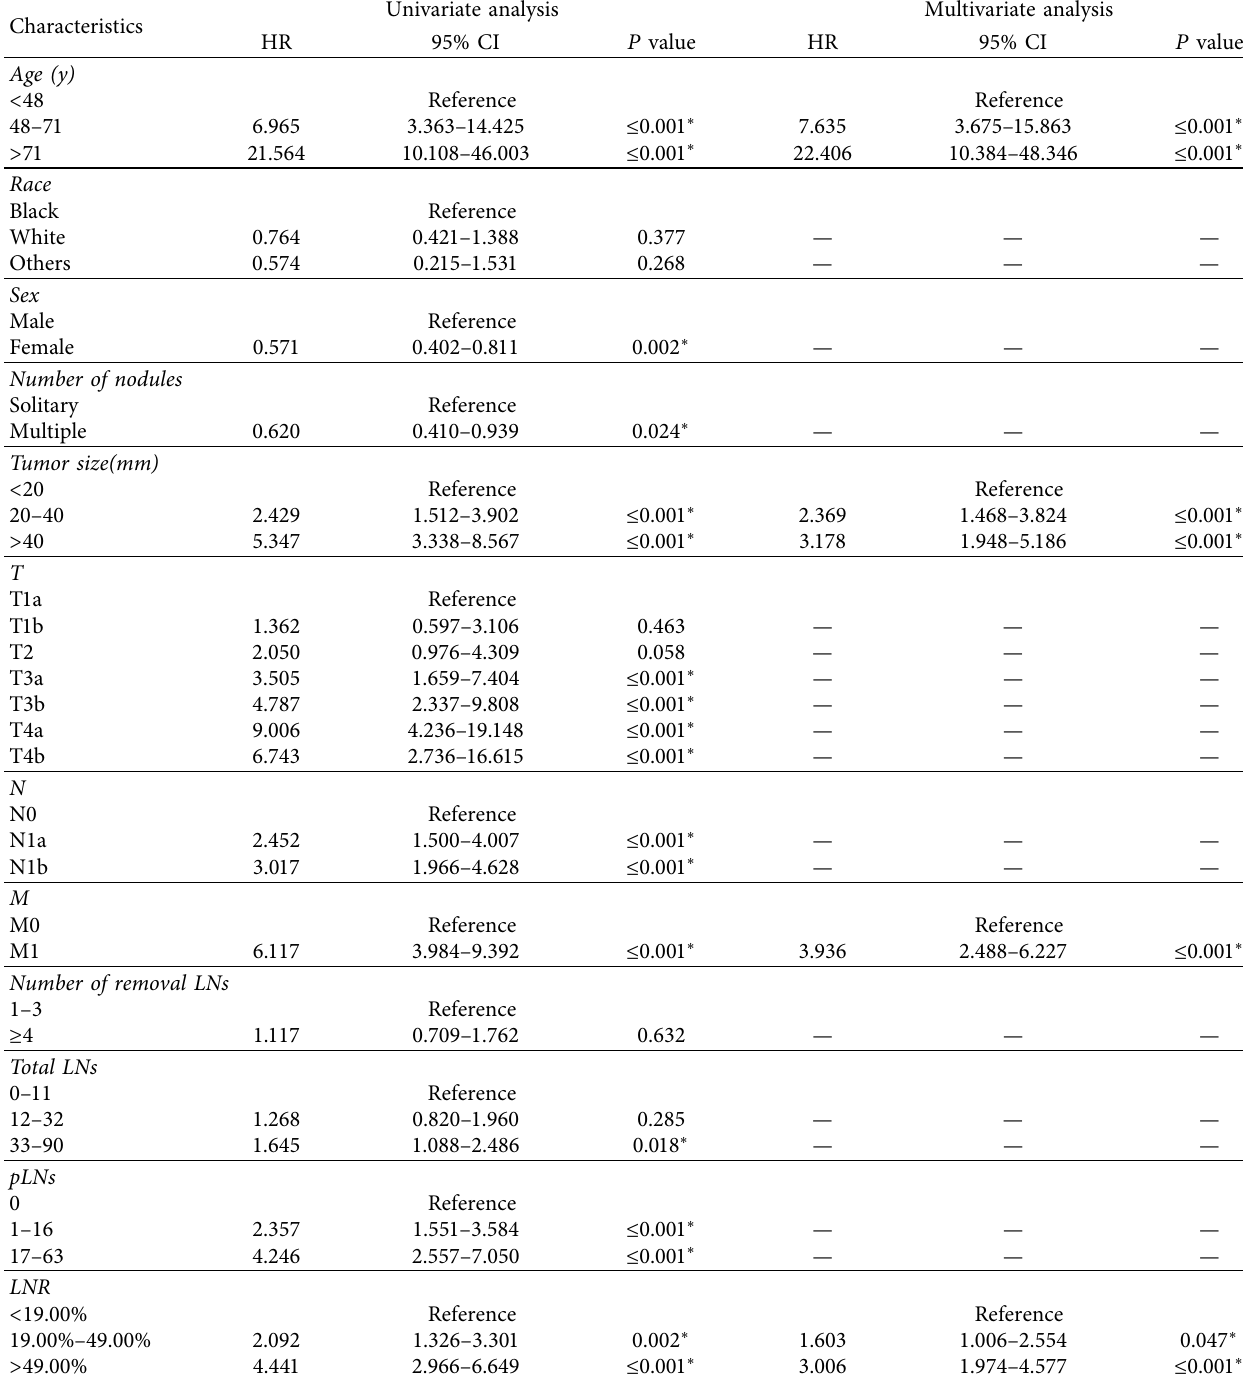
Table 2: Univariate and multivariate cox regression analysis of overall survival (OS) in the training cohort.